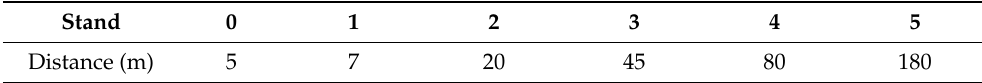
Table 1. Distance of stands from the guide strip of the